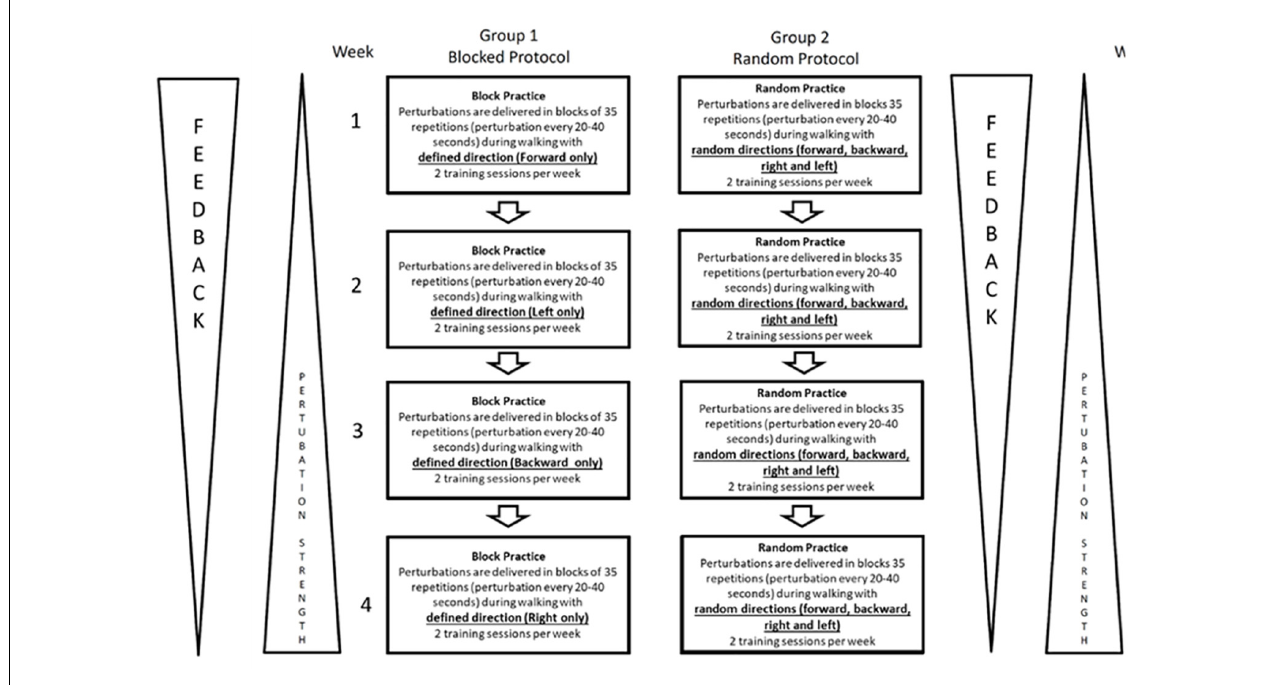
FIGURE 2 | Details of the intervention training